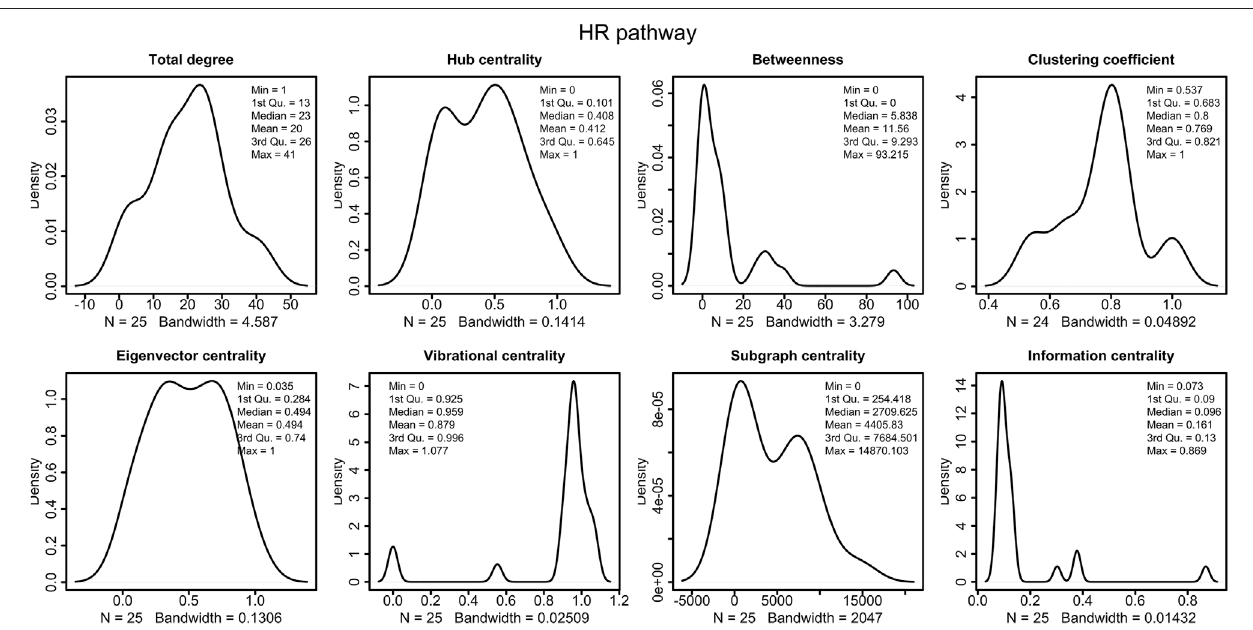
FIGURE 3 | Distributions of the centrality measures of HR pathway (Orlic-Milacic, 2015). We observe that the majority of node have low betweenness, low information centrality and high vibrational